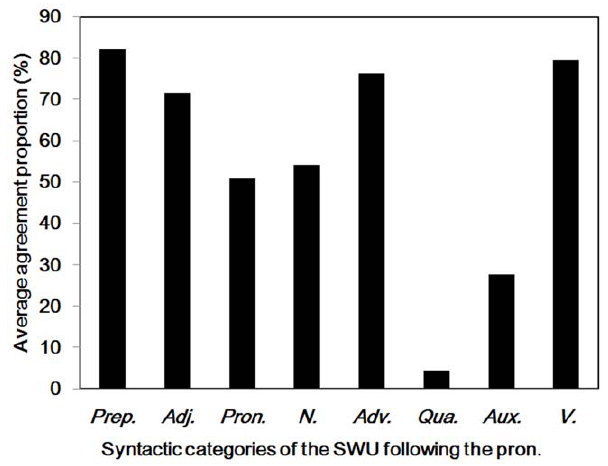
Figure 16. Verbs and subsequent words. Average agreement proportions for word boundaries between the verbs and different subsequent syntactic categories of SWU. Adj.=adjectives; Adv.=ad- verbs; Aux.=auxiliary words; Conj.=conjunctions; N.=nouns; Pre- p.=prepositions; Pron.=pronouns; V=verbs.